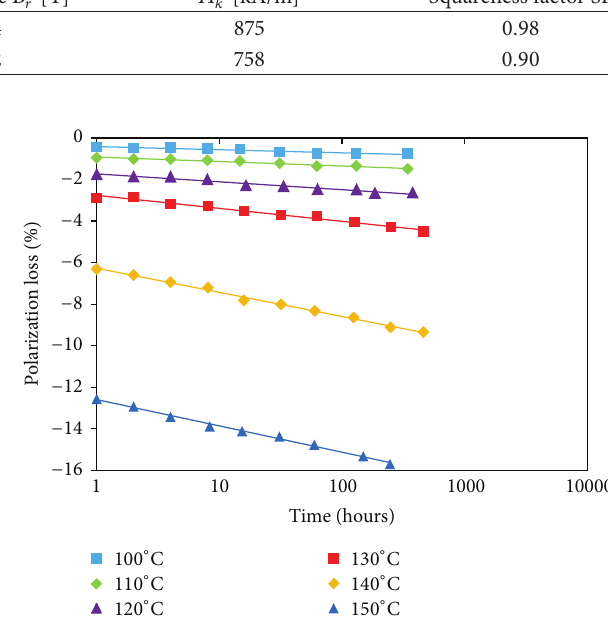
Figure 5: Polarization losses as a function of time at different temperatures in material 2